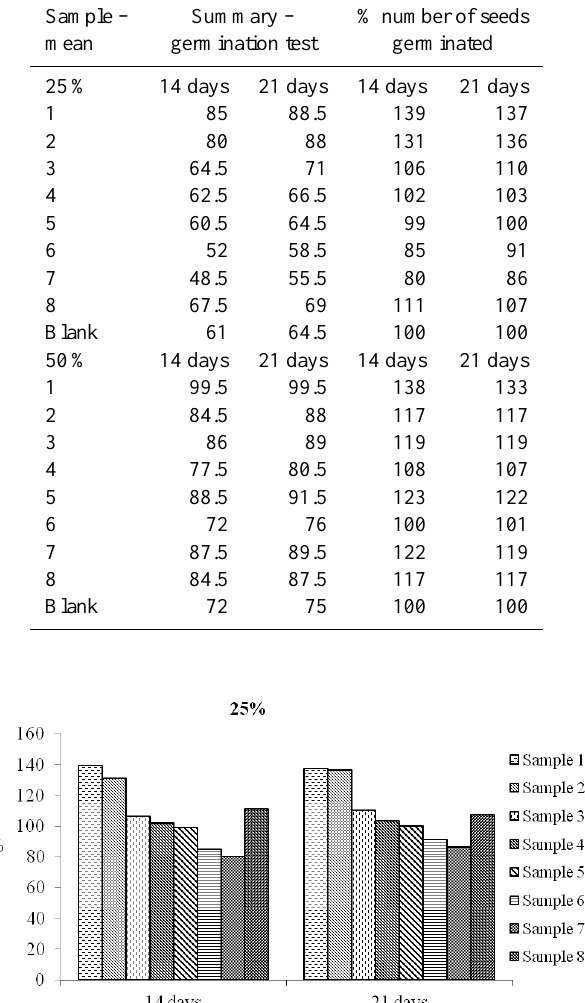
Table 2. Average values and percentages of germination capacity of seeds of white mustard for examined samples.